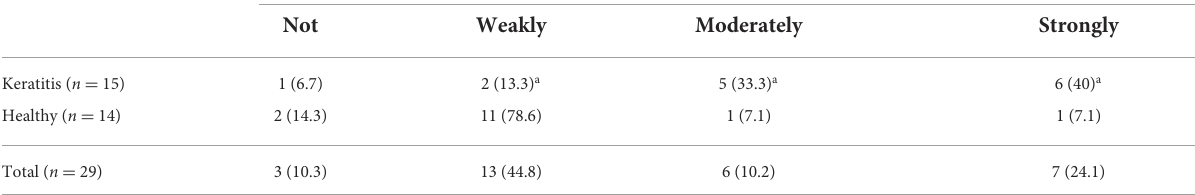
TABLE 8 Biofilm-forming ability of 29 strains of S. pseudintermedius .